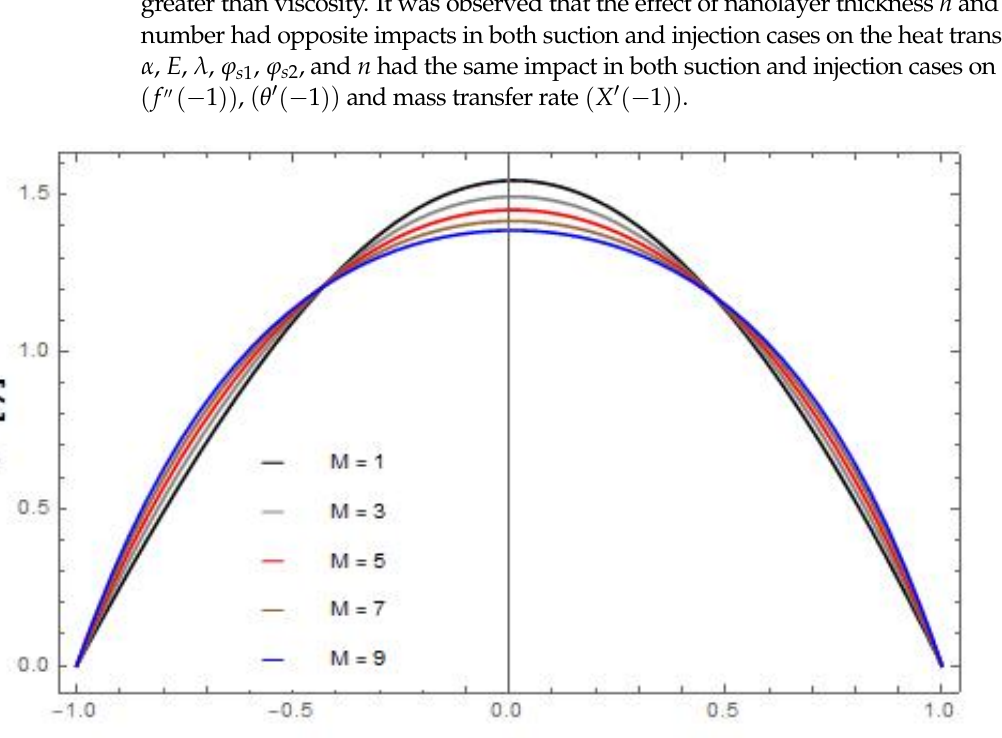
Figure 3. Effect of activation energy on mass concentration.